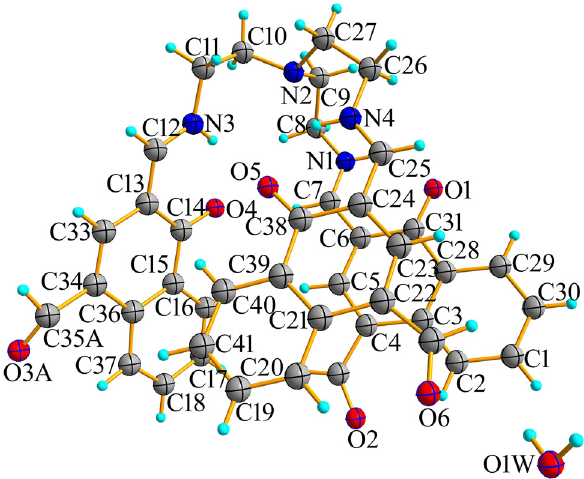
Table  : Data collection and